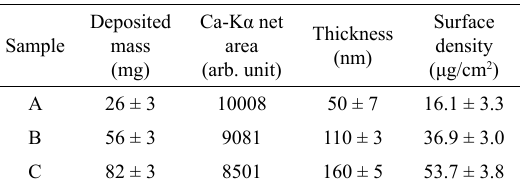
O samples calculated by attenuation of 2 5